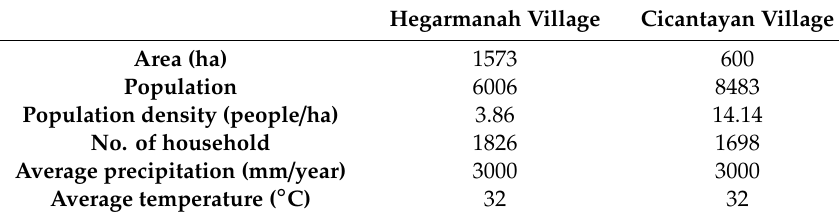
Table 1. General information of the Hegarmanah village and the Cicantayan